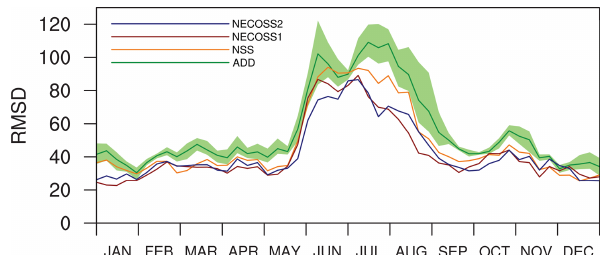
Figure 8. The same as Fig. 4 except for the ADD (dark green solid line), NSS (dark orange solid line), NECOSS1 (dark red solid line), and NECOSS2 (navy blue solid line) experiments. The green shaded band denotes the minimum and maximum RMSD across three random addition